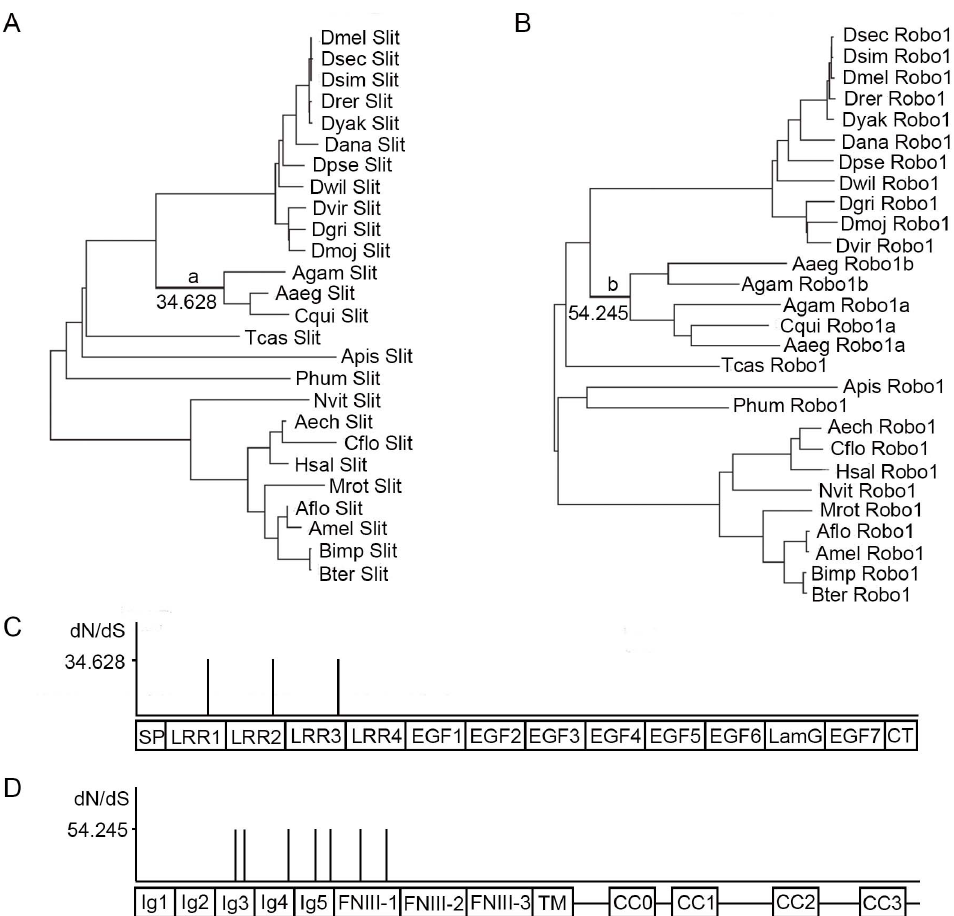
Figure 2. Positive selection of slit and robo1 in insects. (A and B) Phylogenetic trees of slit (A) and robo1 (B) in insects. Both of slit and robo1 under positive selection were detected along the mosquito lineage. The v values for sites under positive selection along the mosquito lineage were marked. a and b indicate the mosquito lineage. Taxa names are abbreviated with the first letter of the genus and the first three letters of the species. (C and D) Mapping positively selected sites to the Slit (C) and Robo1 (D)